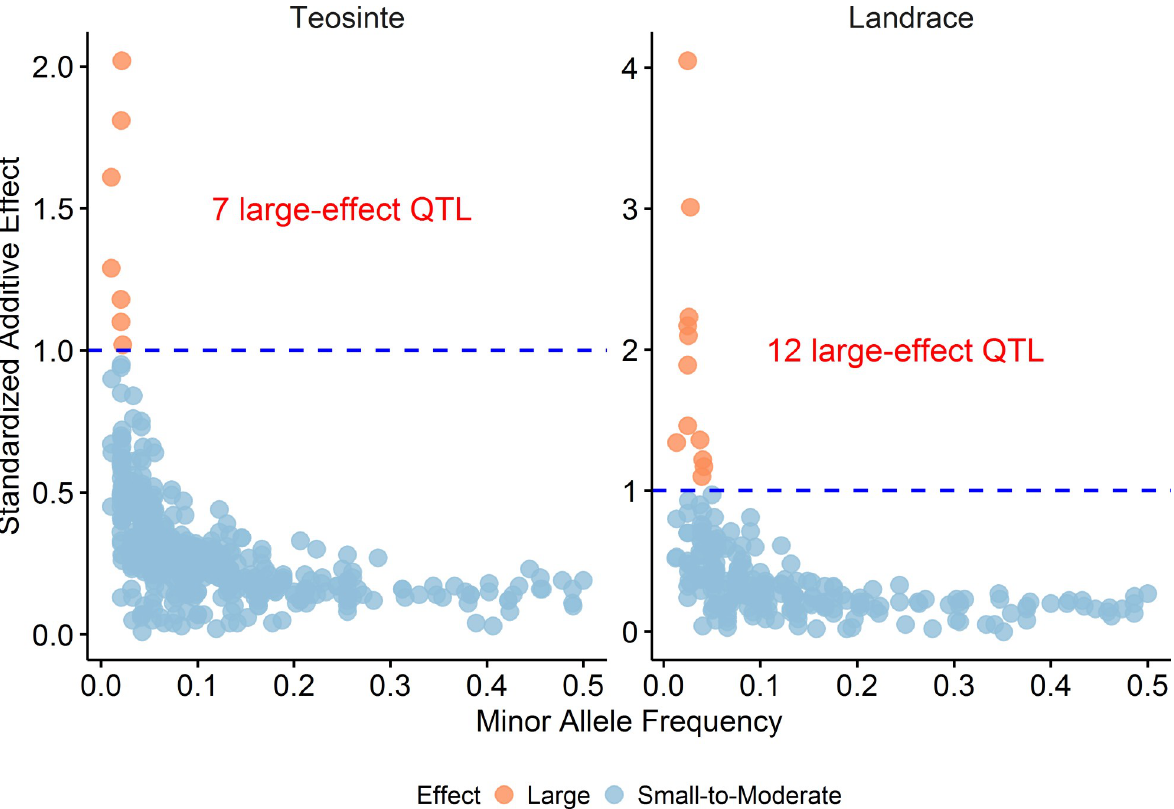
Fig 2. The relationship between effect size and minor allele frequency (MAF). The standardized additive effect, calculated as additive effect by phenotypic standard deviation in absolute value, is plotted against MAF for each QTL. MAF was calculated from parent data. Large effect QTL is defined as a QTL with a standardized additive effect greater than 1 phenotypic standard deviation as indicated by blue dotted lines.